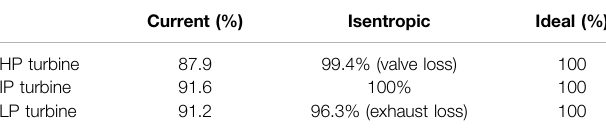
TABLE 5 | Steam turbine ef fi ciency summary. Current (%)